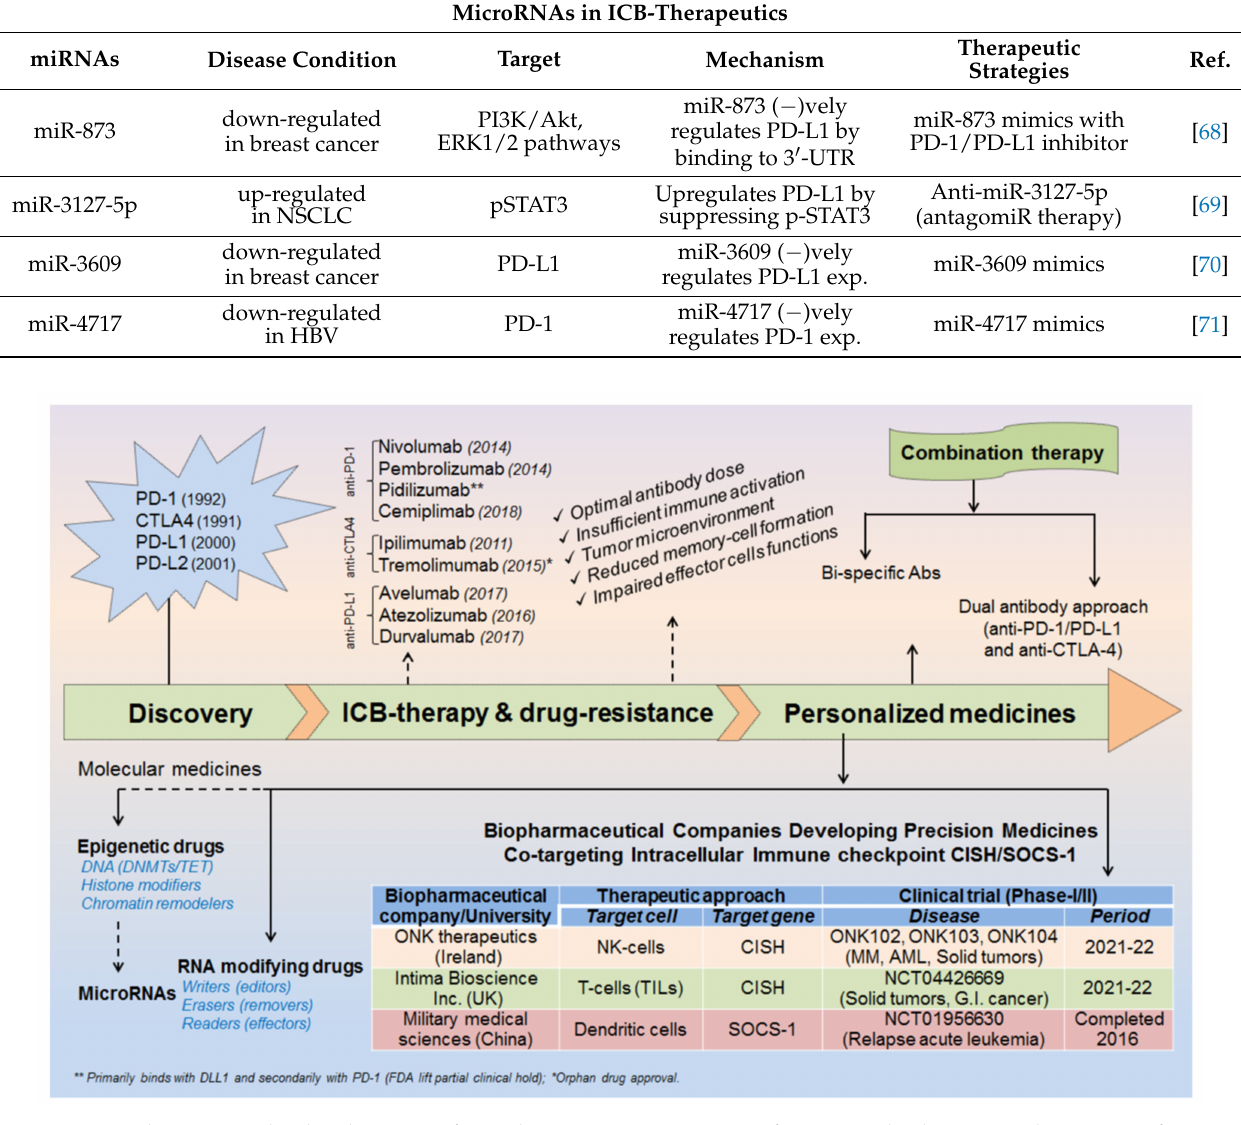
Figure 1. Milestones in the development of ICB-therapeutics. Discovery of immune checkpoint markers. Year of FDA- approved ICB-antibodies. Factor affecting antibody/drug-resistance. Recent strategies to improve ICB-efficacy by combining molecular medicines. Biopharmaceutical companies developing personalized medicines co-targeting epitranscriptomics and intracellular immune checkpoint (CISH/SOCS-1) in NK-cells, TILs and DCs with relevant clinical trial were